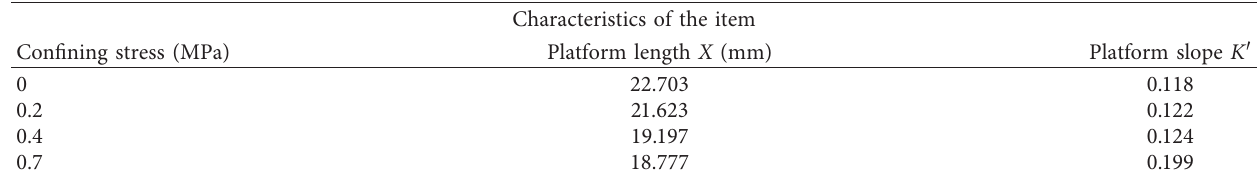
Figure 16: Load-displacement curve, failure morphology, and mechanism diagram of interface between the anchor and the surrounding rock. (a) Drawing curve and damage pattern diagram. (b) Failure mechanism Table 2: Platform characteristics statistics.